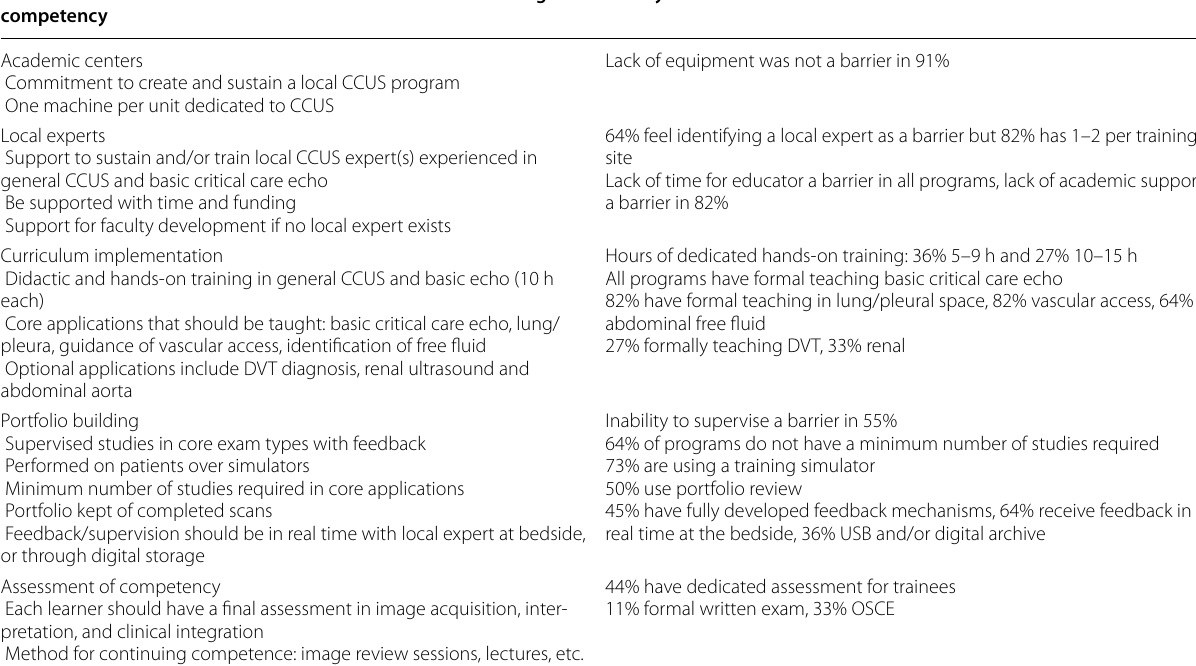
Table 4 Comparison of Canadian CCUS recommendations [16] to the current state Canadian recommendations for critical care ultrasound training and